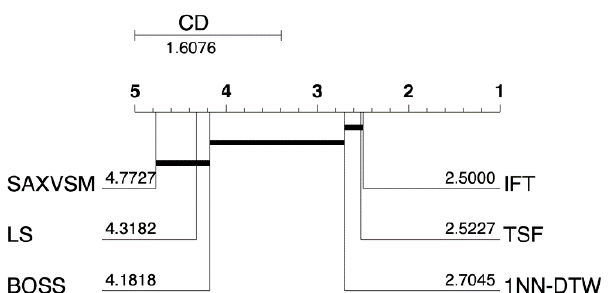
Figure 5. Critical difference diagram for six classifiers derived from results in Table 3. LS: Learning